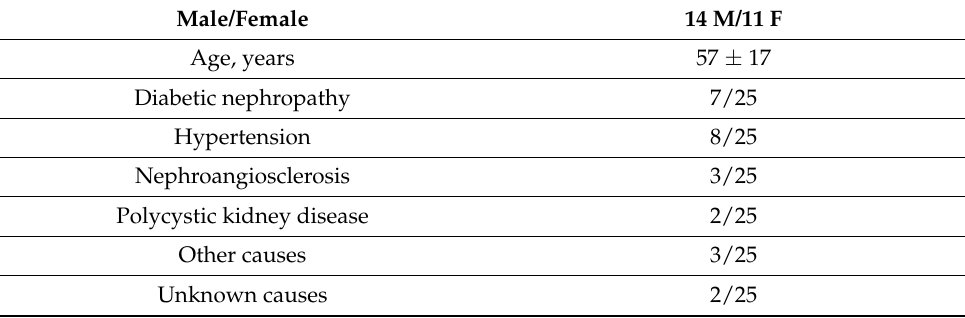
Table 1. Characteristics of the study population.